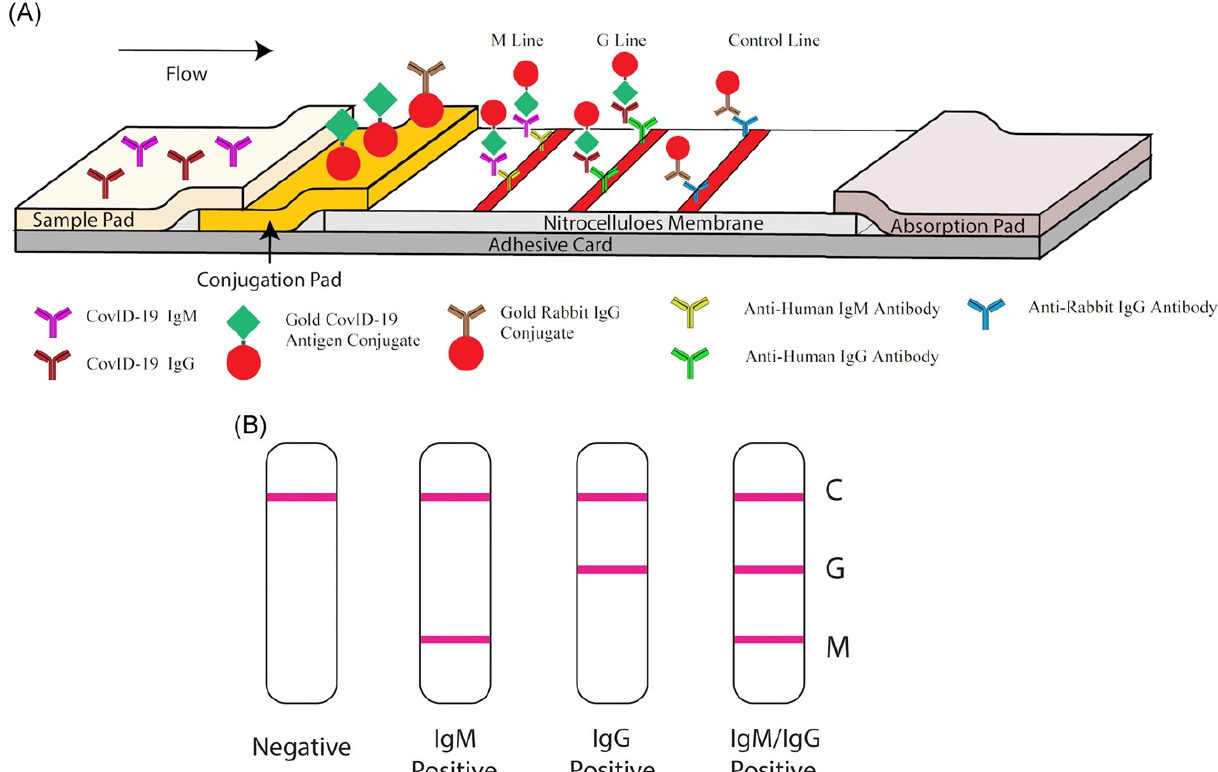
Figure 5. Rapid detection kit for SARS-CoV-2 based on combined IgM-IgG antibody: ( A ) The LFIA device for POC diagnostics of SARS-CoV-2. ( B ) Demonstration of the test results (reproduced with permission from Li, Z. et al., J. Med. Virol., 2020, 92, 1518–1524 [72]).